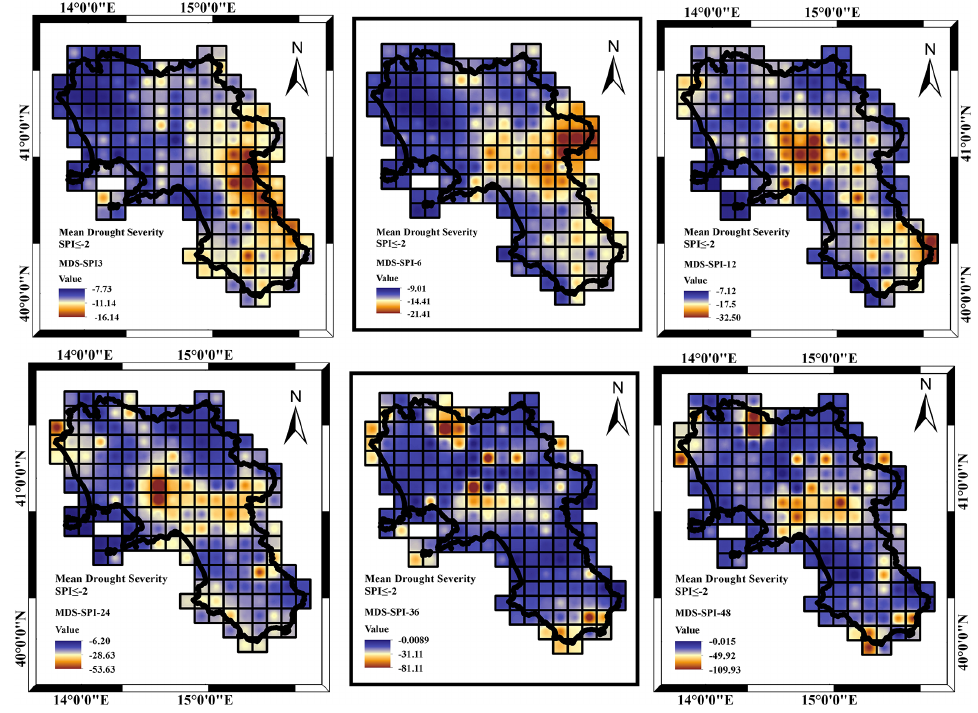
Figure 12. MDS (mean drought severity) for the different accumulation periods considered (SPI ≤ − 2).